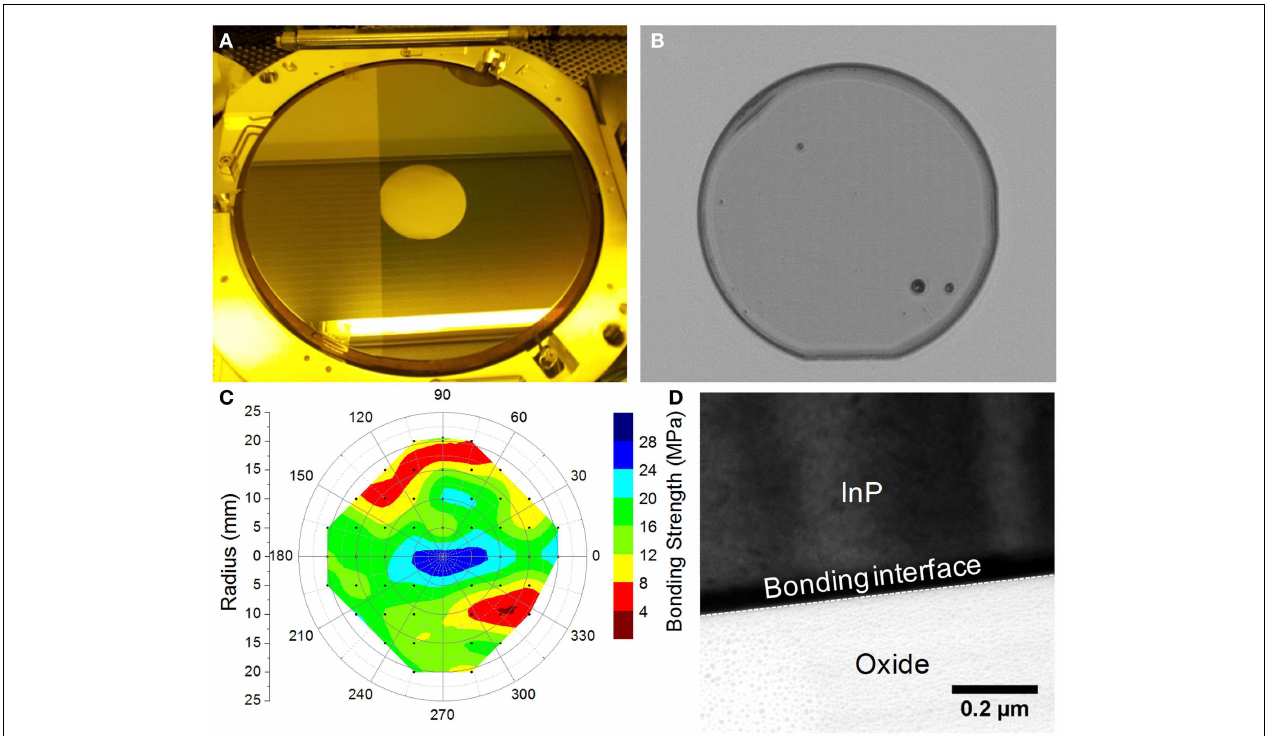
FIGURE 2 | (A) The bonded wafer before unloading from the EVG bonder. (B) The CSAM result. (C) The shear testing result. (D) TheTEM results show the high-quality bonding interface.